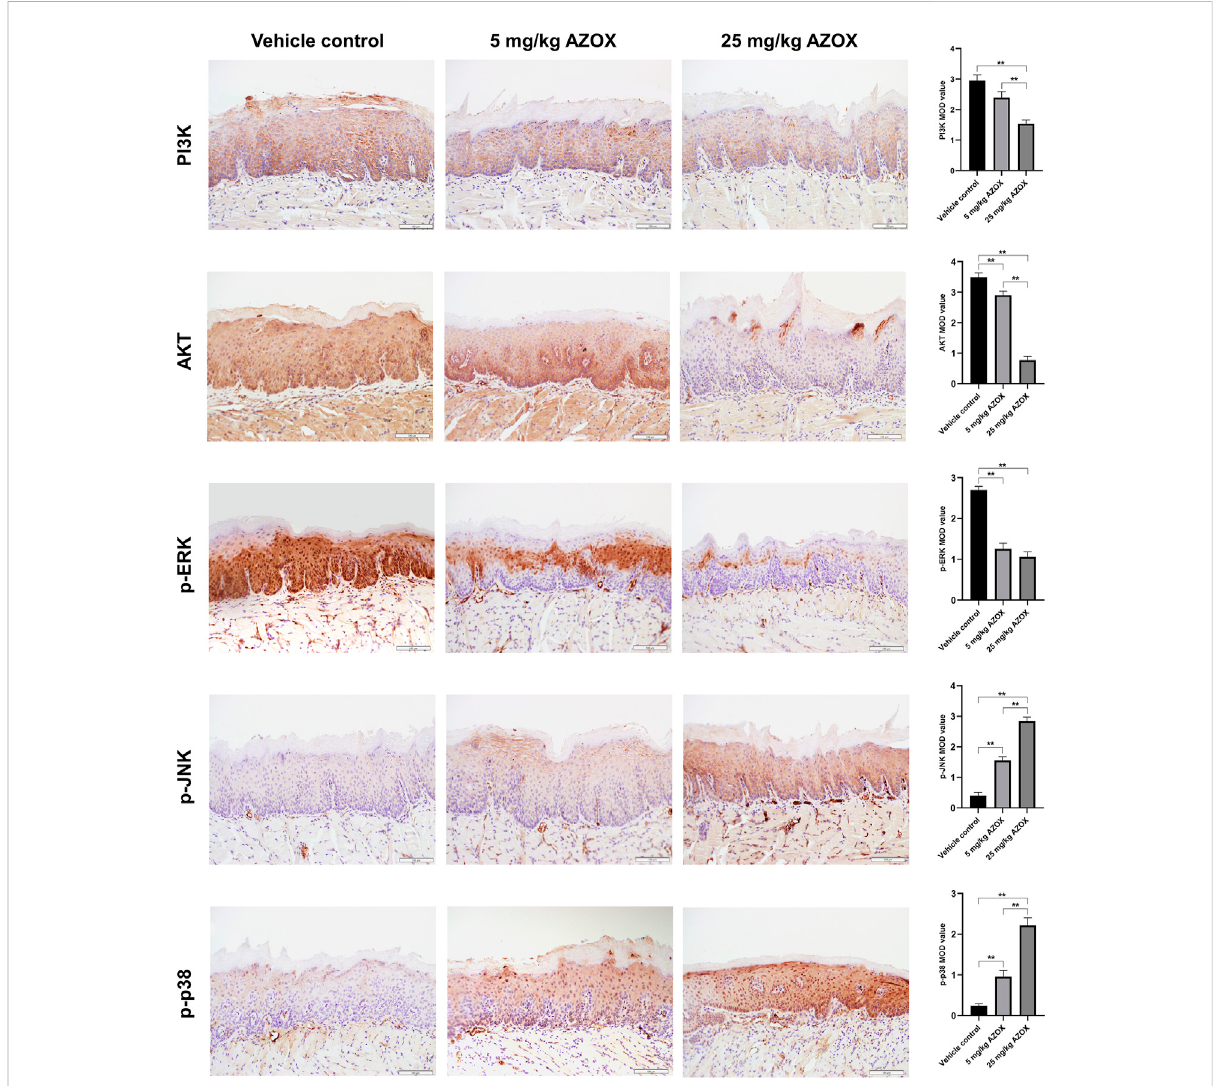
FIGURE 4 AZOX induces apoptosis via PI3K/AKT and MAPK pathways in mouse OLK tissues. The expression of PI3K, AKT, and MAPK pathway relative markers p-ERK, p-JNK, p-p38 was measured in mouse OLK tissues of the vehicle control group, the low and high-dose AZOX group by IHC (magni fi cation 200 × ). The IHC images were calculated using Image-Pro Plus software 6.0 and the results were shown as bar graphs. ** p <